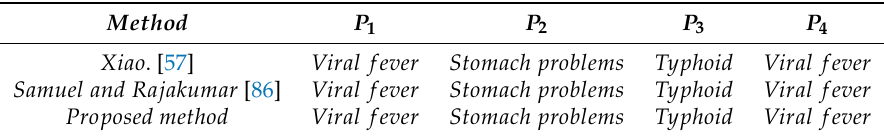
Table 9. The results generated by other methods in Example